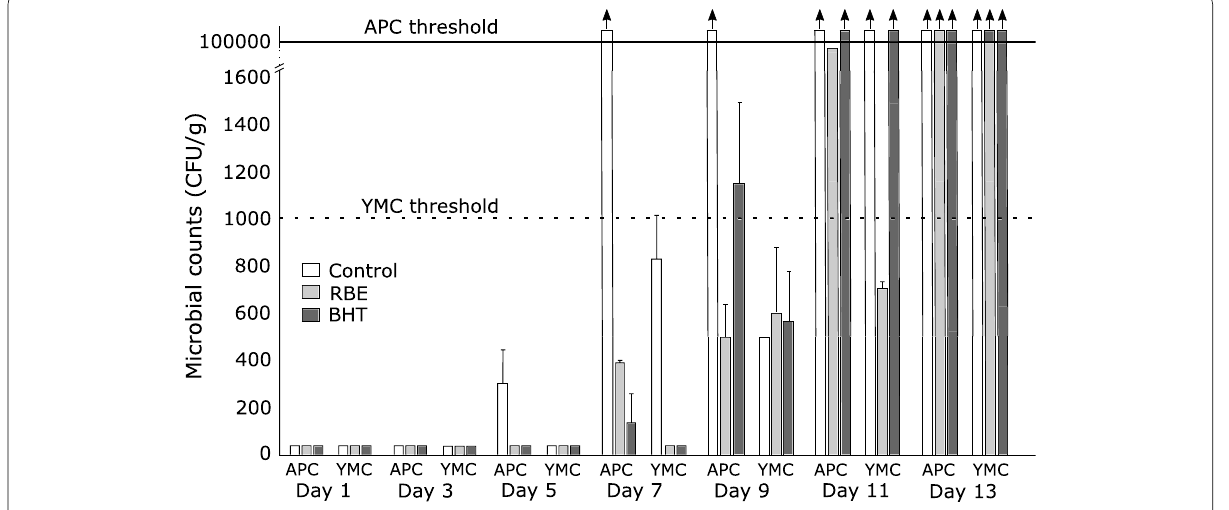
Fig. 2 Effect of antioxidants on the microbial shelf-life of vanilla cakes baked at 160 °C ( n